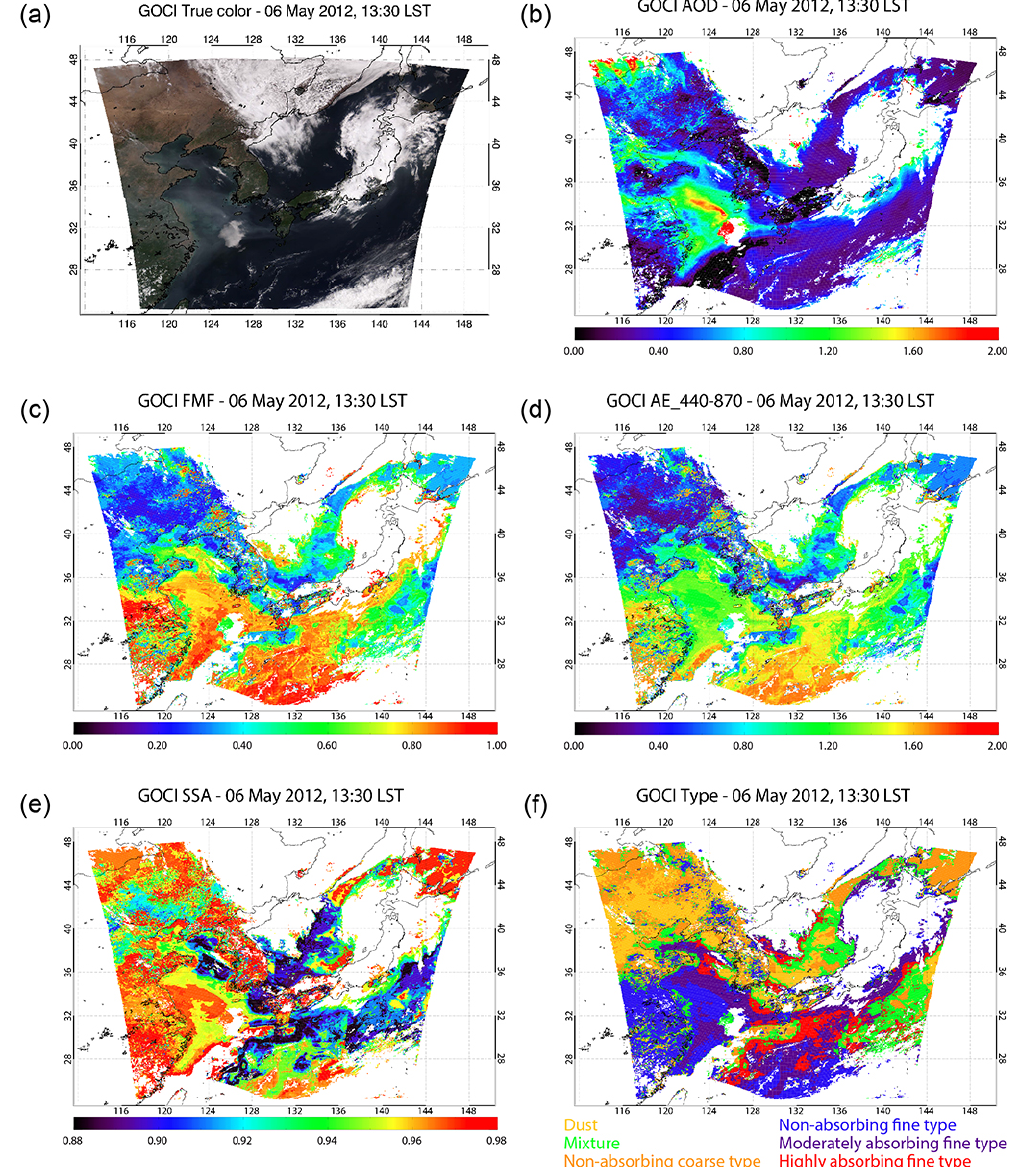
Figure 6. Images of (a) GOCI true color, (b) AOD at 550nm, (c) FMF at 550nm, (d) AE between 440 and 870nm, (e) SSA at 440nm, and (f) type for 6 May 2012, 13:30LST. Aerosol types are colored yellow (dust), green (mixture), orange (non-absorbing coarse type), blue (non-absorbing fine type), purple (moderately absorbing fine type), and red (highly absorbing fine